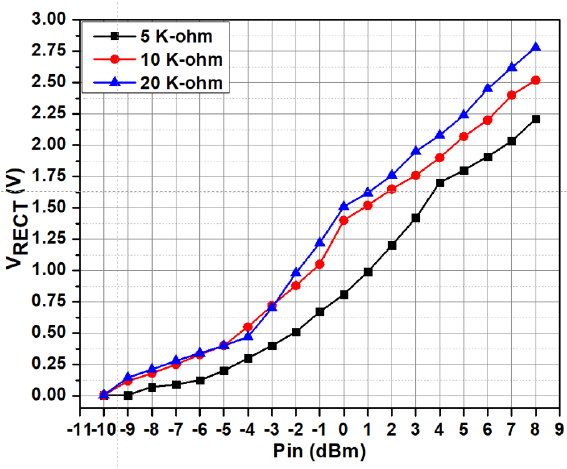
Figure 20. Output voltage of the RF-DC converter at multiple RF input power levels.